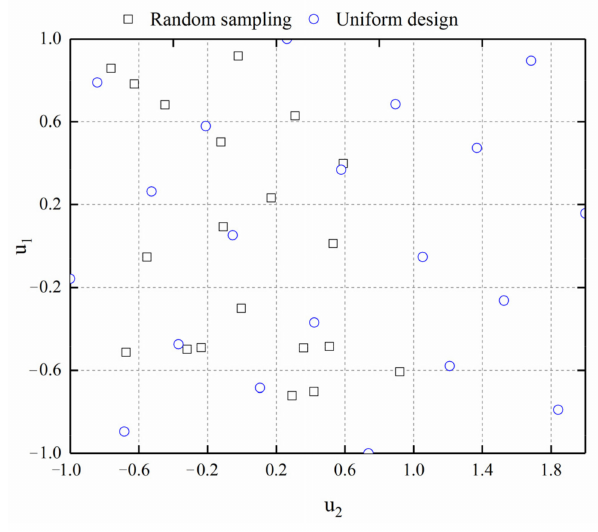
Figure 2. Distribution of samples produced by uniform design and random